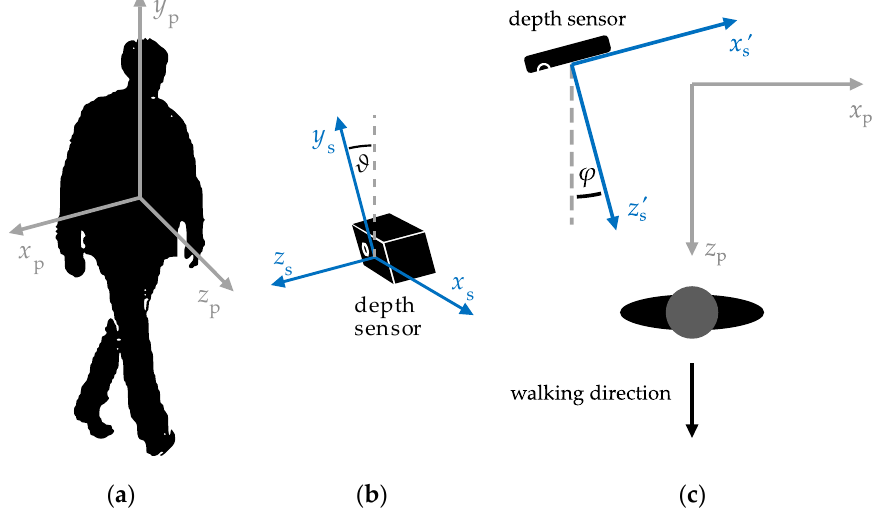
Figure 2. ( a ) The coordinate system ( x p , y p , z p ) associated with the examined person, in which the x p axis corresponds to that person’s medio-lateral axis, the y p axis—to that person’s vertical axis and the z p axis—to that person’s anteroposterior axis; ( b ) The angle ϑ of rotation necessary to make one of the coordinate axes associated with the depth sensor parallel to the examined person’s vertical axis; ( c ) The angle ϕ of rotation necessary to make one of the coordinate axes associated with the depth sensor parallel to the examined person’s walking